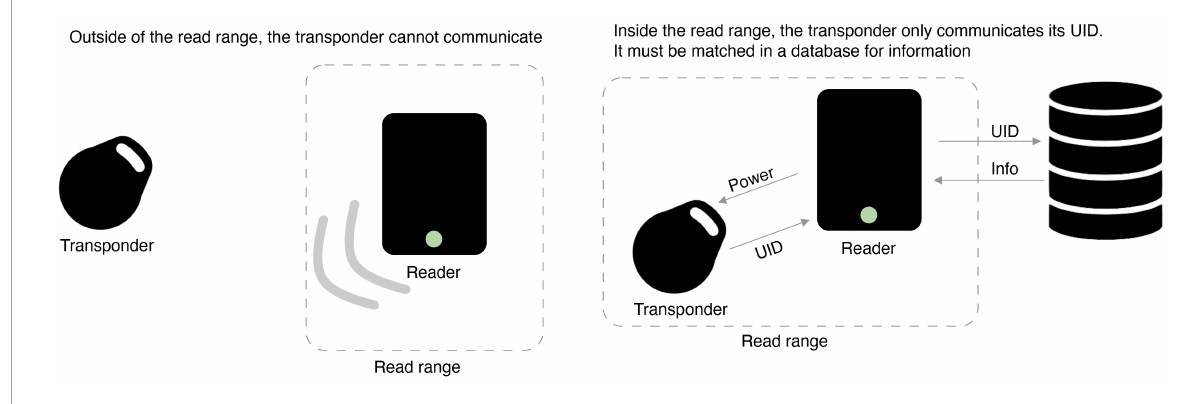
FIGURE1 How transponders communicate with readers.